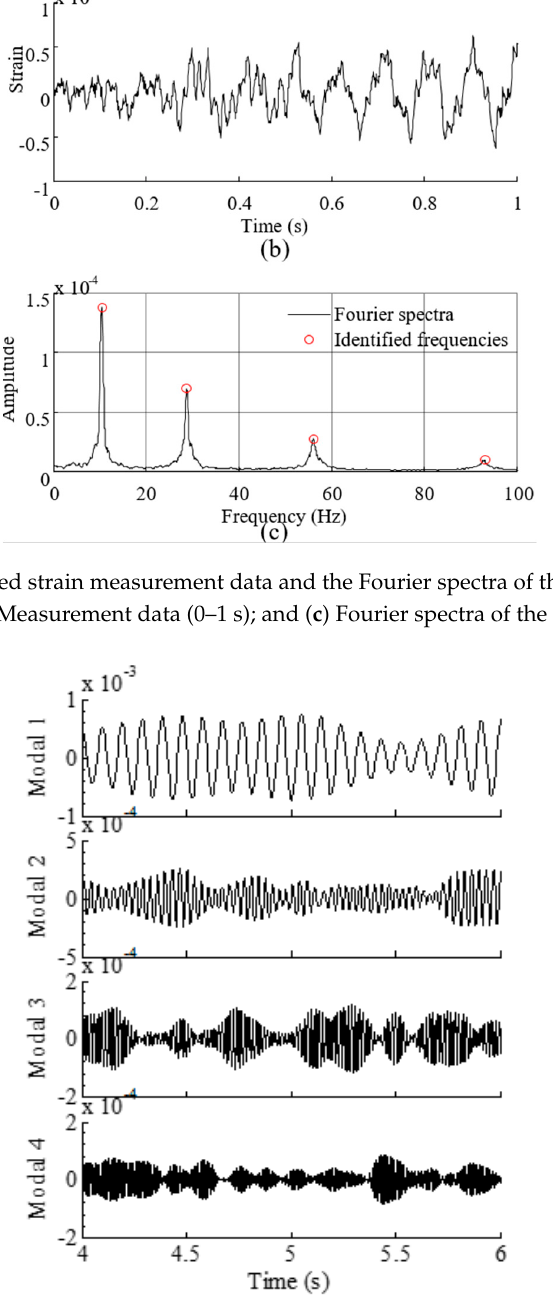
Figure 4. Four modal responses of the strain measurement data obtained using EMD method with intermittency criteria.